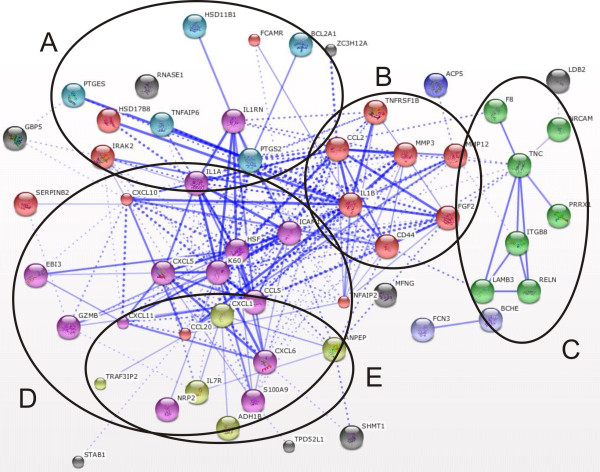
The gene functional clusters identified for the significant, overlapping adipose and liver tissue transcriptomes. The overlapping (shared) upregulated adipose tissue (n = 7) and liver tissue (n = 5) significantly changed transcriptome. The overlapping (shared) upregulated adipose tissue and liver tissue significantly changed transcriptome. Within the overlapping network we identified functional clusters related to: (A) (anti)apoptosis/inflammation; (B) mobilization of T-lymphocytes and monocytes; (C) matrix remodelling; (D) T and B cell activation and functioning; (E) interleukin 7 receptor activity.